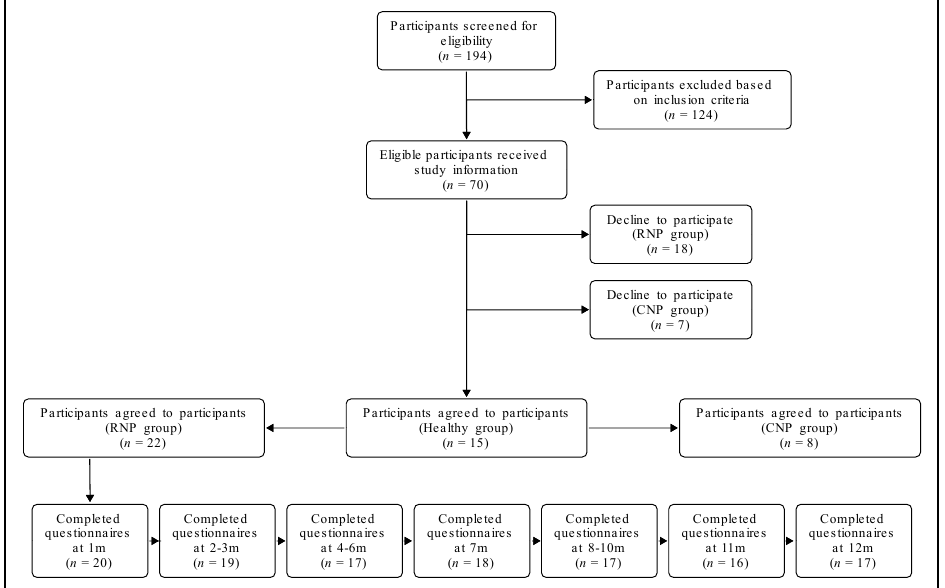
Figure 1. Flowchart of study population.